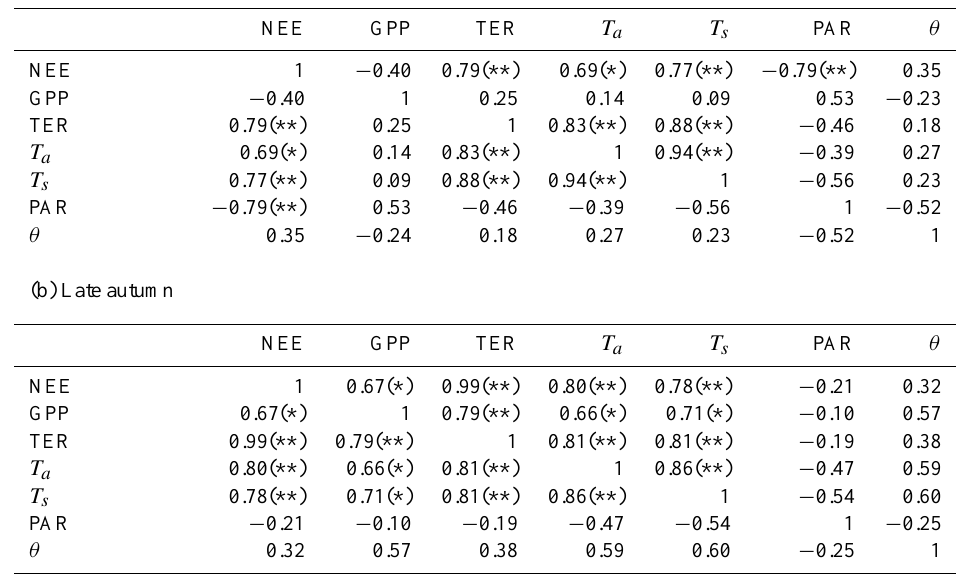
Table 1. Bivariate correlation coefficients (N=11) between cumulative carbon balance (NEE), its components (GPP, TER) and mean climate variables air ( T a ) and soil temperature ( T s ), photosynthetically active radiation (PAR) and volumetric soil moisture content ( θ ) in early (September–October) and late autumn (November–December). Statistically significant correlations are marked with ** (2-tailed p < 0 . 01) and * (p < 0 . 05)